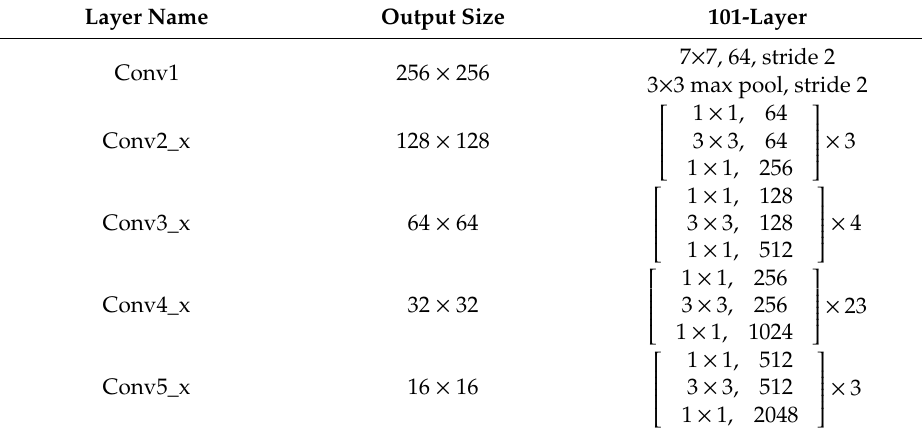
Table 1. The network configuration of the Encoder